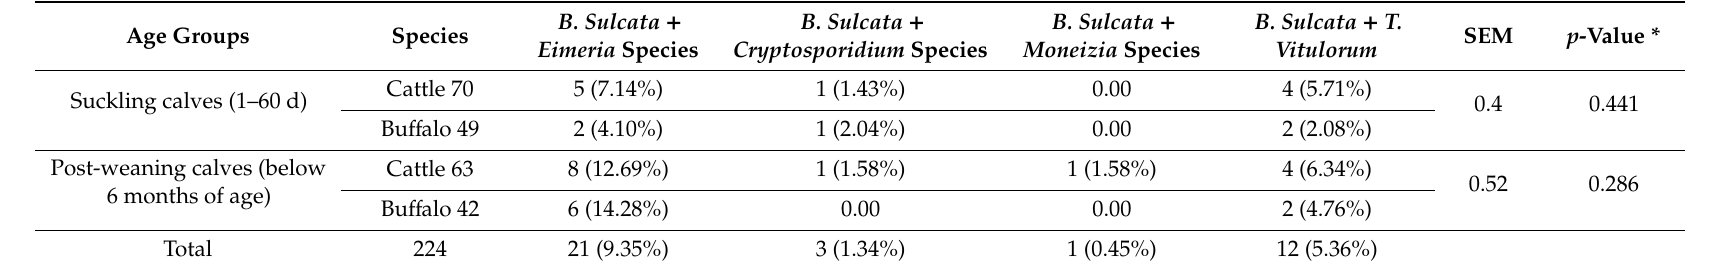
Table 4. Prevalence rate of B. sulcata co-infection with other parasites in diarrheic